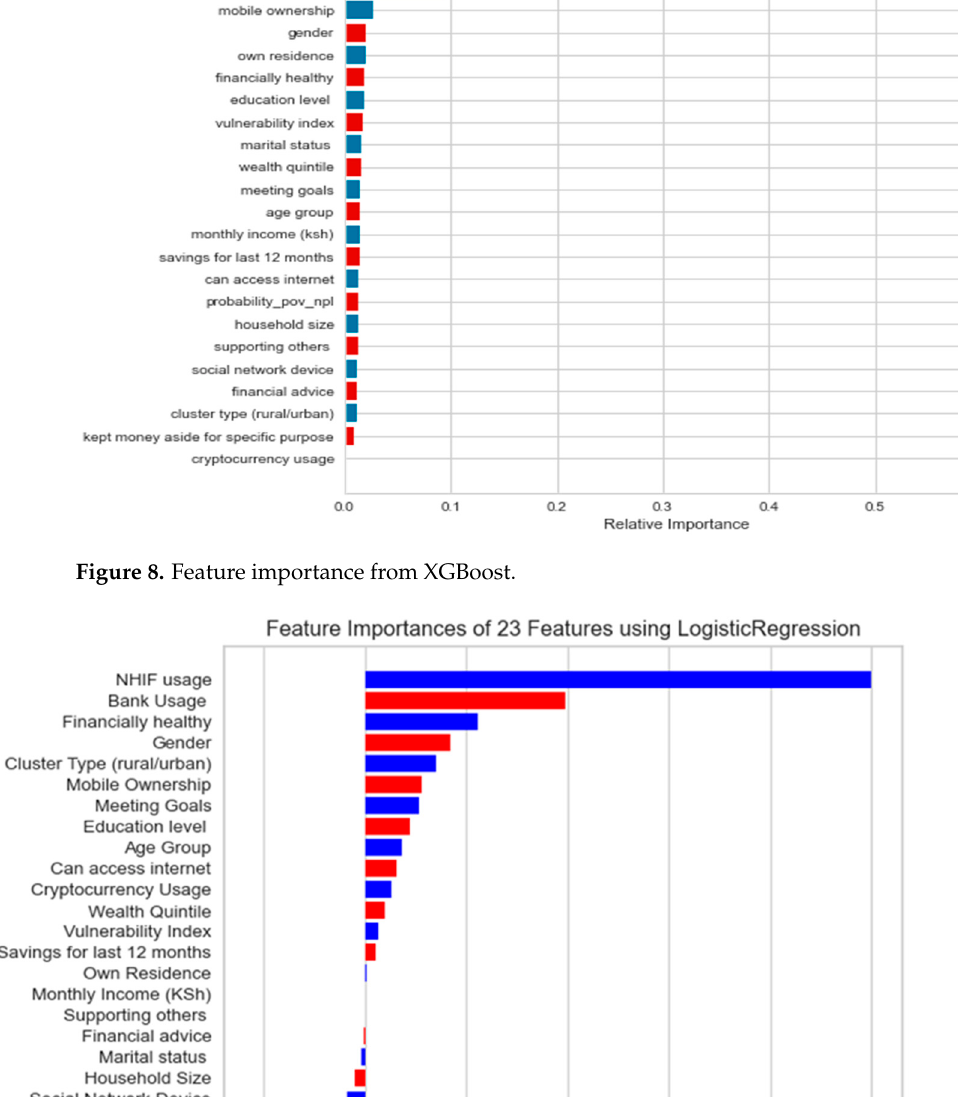
Figure 7. Feature importance from decision tree.